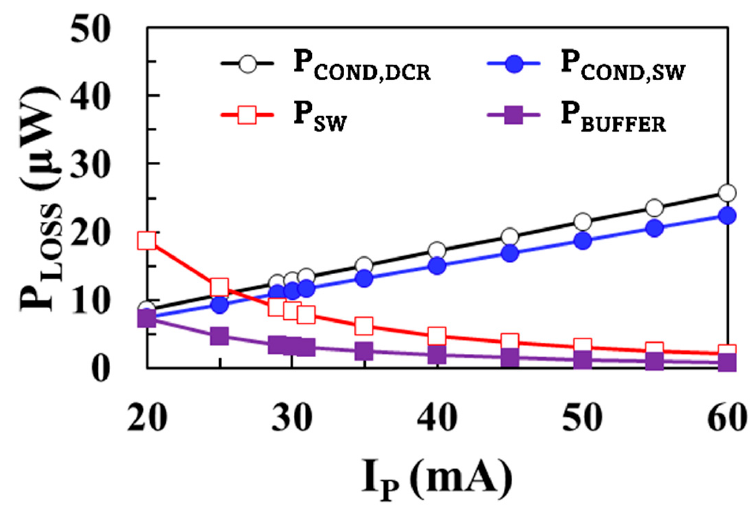
Figure 6. Modeling results of each loss component according to the peak inductor current.